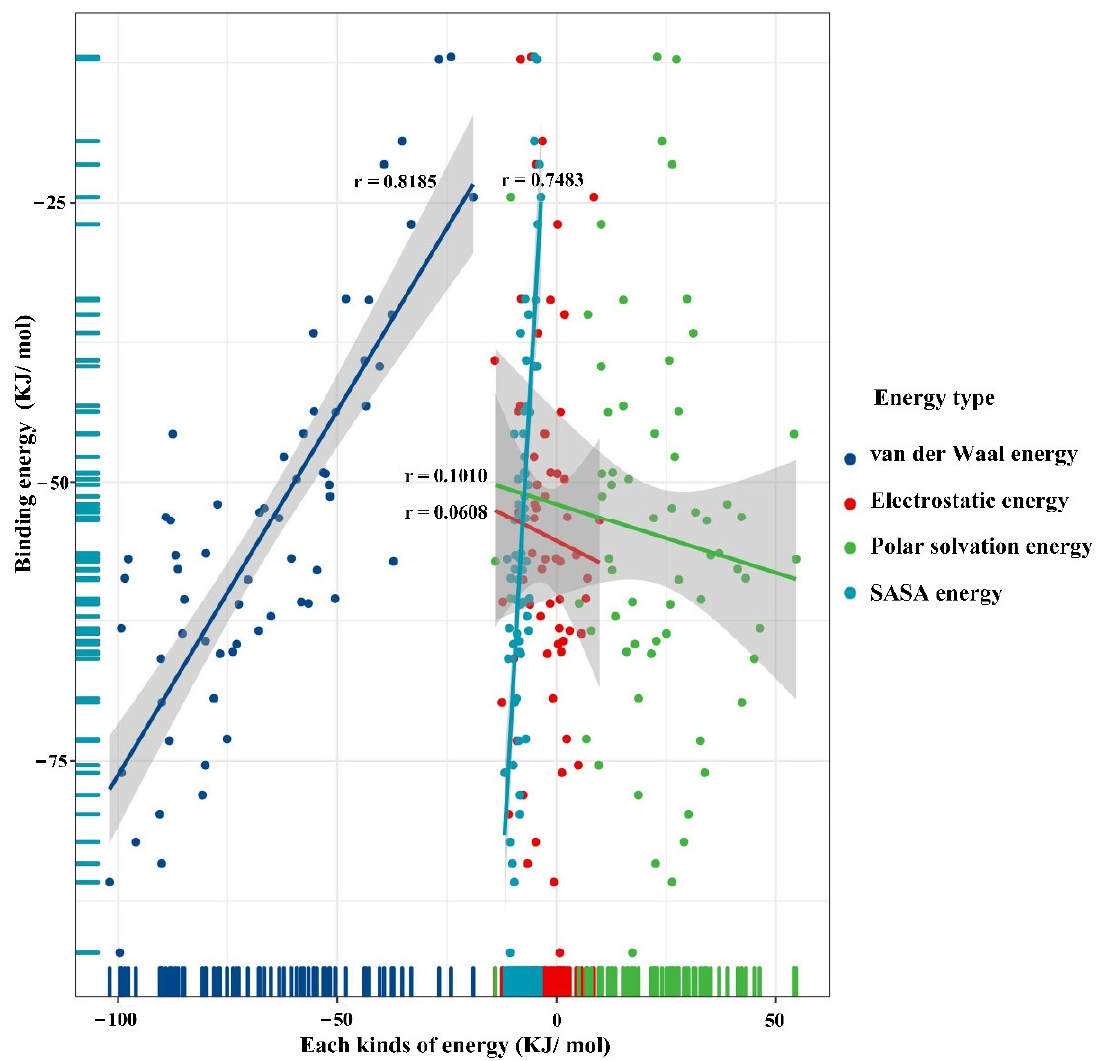
Figure 3. Linear regression investigation of the binding free energy of polystyrene 5 polymers.